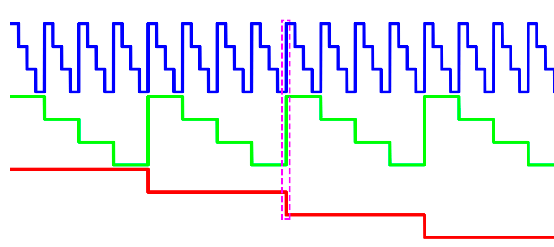
Figure 2. The n -ary gray-level ( n GL) method.